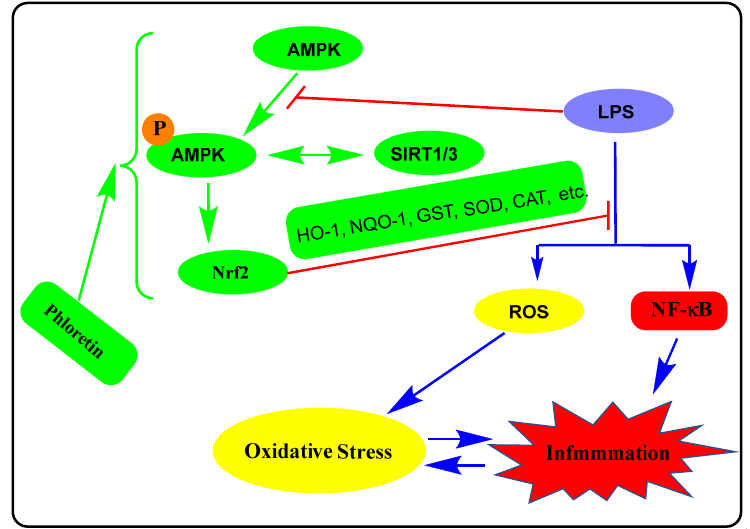
Figure 3. The crosstalk between AMPK, Nrf2, and SIRT1 pathways in the anti-inflammatory effect of phloretin. The activation of AMPK and SIRT1 are closely related in the regulation of metabolism and pathologies such as oxidative stress and inflammation. Activation of AMPK by phloretin via its phosphorylation as well as increased expression of SERT1 have been associated with its anti-inflammatory effect and modulation of lipid metabolism such as inhibition of lipid accumulation. This activity was further shown to be related to the induction of Nrf2 that suppresses both the oxidative stress and inflammatory pathways induced by a variety of agents including LPS. Increased SERT3 activity by phloretin is also reported. The red line shows the inhibitory response.